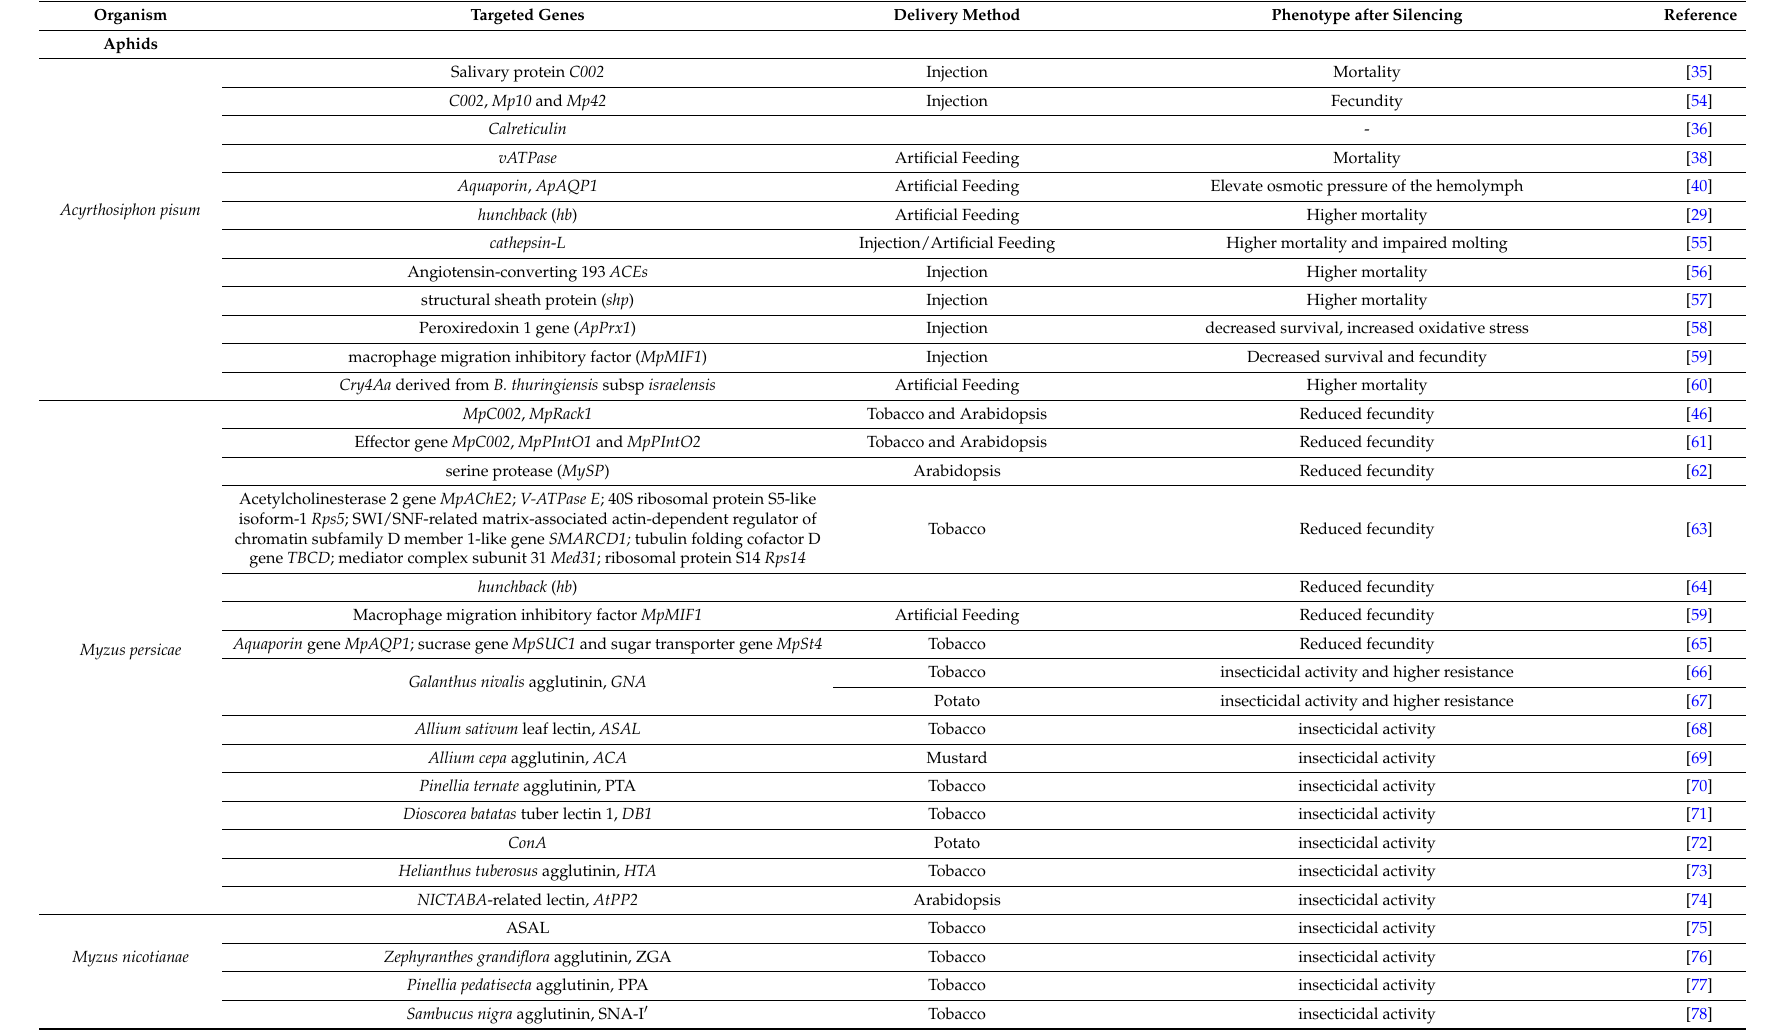
Table 1. Reported cases of gene silencing in insect vector for plant